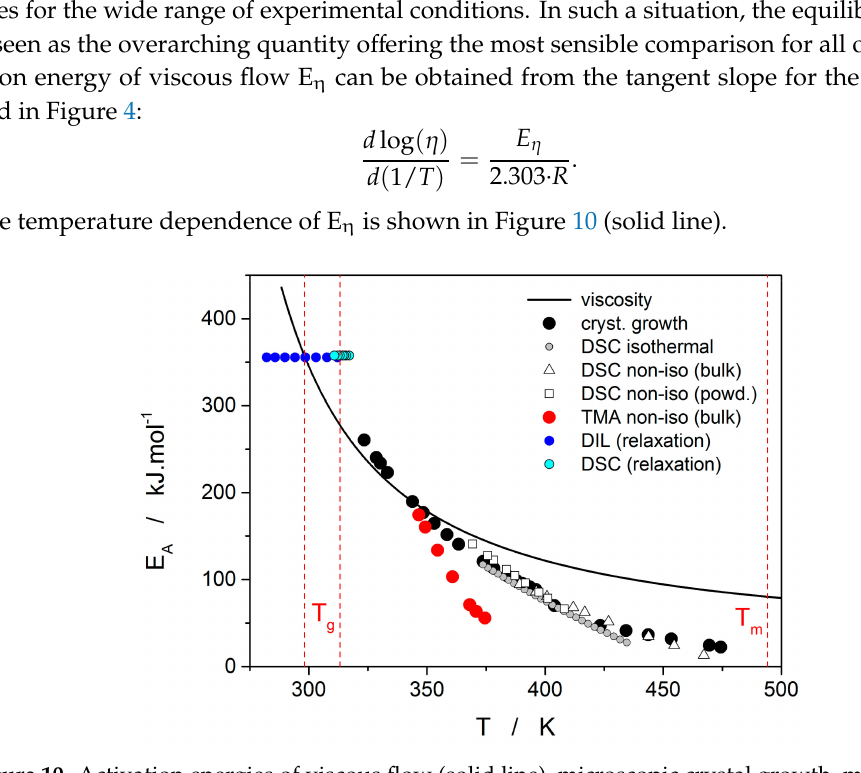
Figure 10. Activation energies of viscous flow (solid line), microscopic crystal growth, macroscopic crystallization observed by DSC (two data series, for bulk and powdered samples) and TMA, as well as structural relaxation observed by DSC and